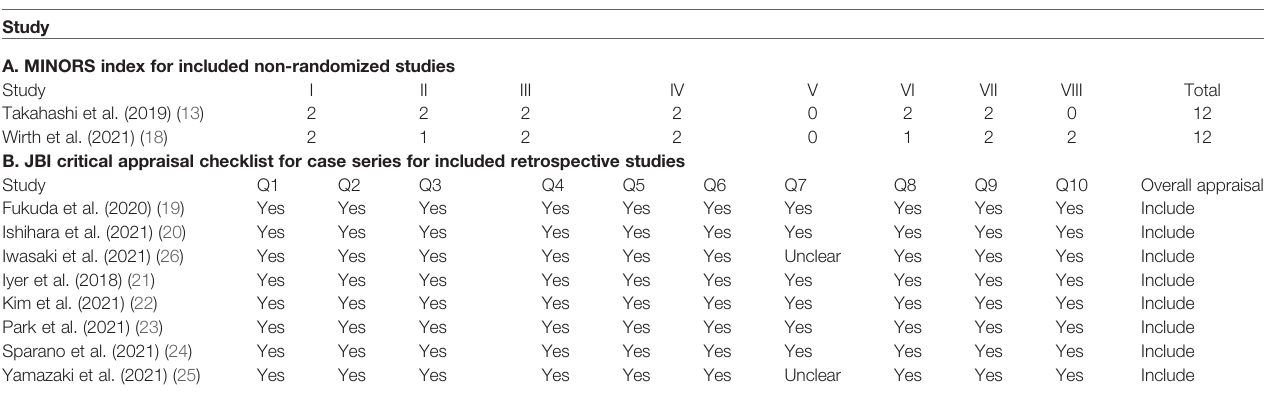
TABLE 2 | Quality assessment of included